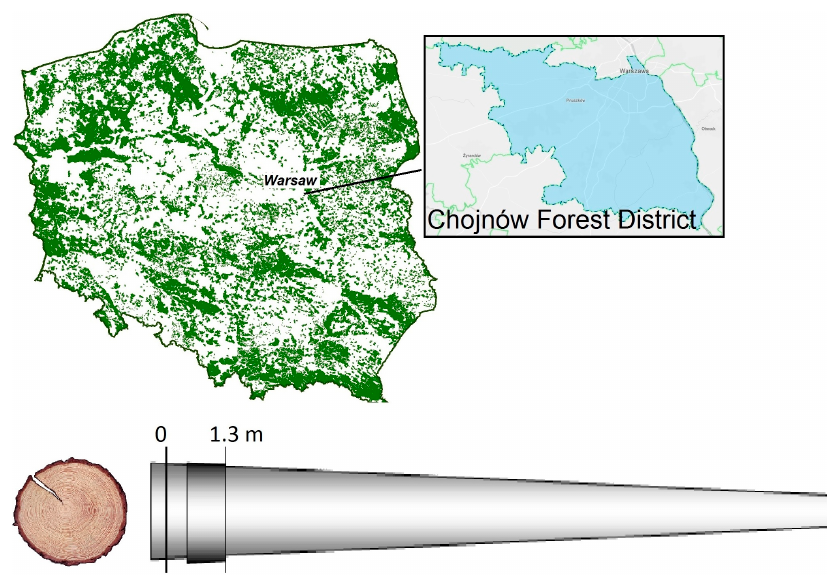
Figure 1. Designation of sampling points for testing along the lying pine trunk.